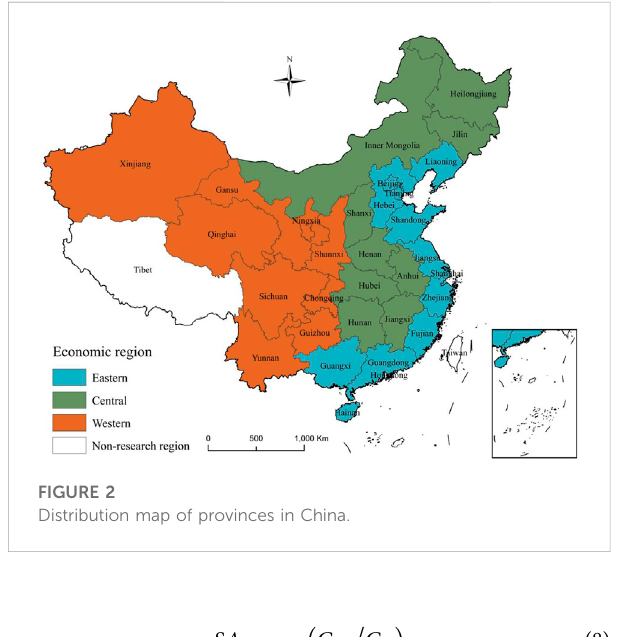
TABLE 2 Variable descriptive